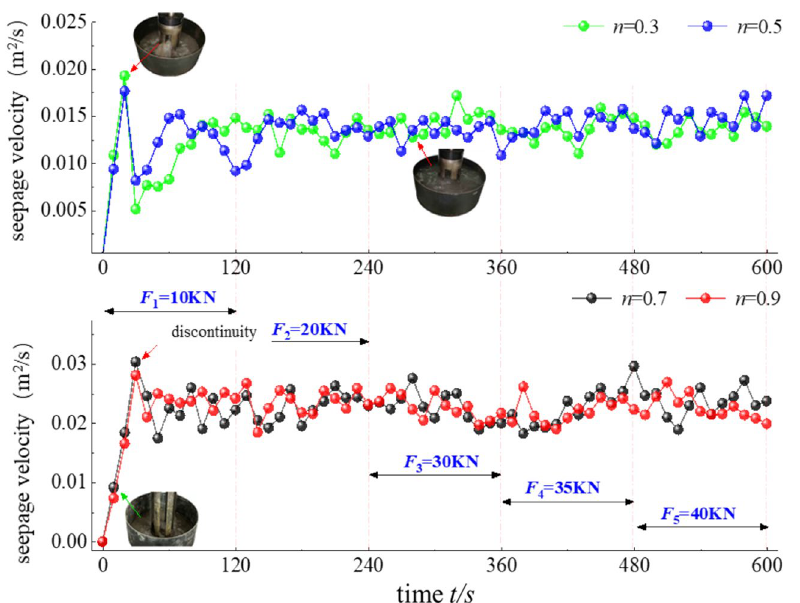
Figure 7. Relationship between the flow rate and